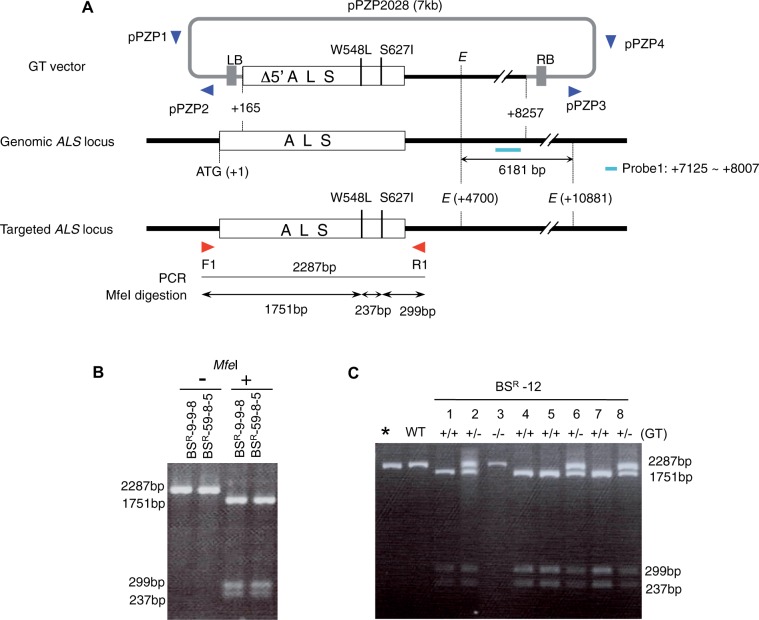
Strategy for T-DNA-mediated GT of the rice ALS locus and analysis of homologous recombination events in T0 plants. Schematic representation of GT events. The white boxes represent the coding region of the ALS gene. The thick black lines represent flanking rice genomic DNA. Left (LB) and right (RB) border sequences are represented by gray boxes. A sequence of 165 bp encoding 55 amino acids including the chloroplast-targeting signal is deleted in the T-DNA region of the GT vector, rendering the ALS gene non-functional. The two mutations (W548L and S627I) that confer BS tolerance exist on the GT vector. The W548L and S627I mutations create novel MfeI restriction sites (CAATTG). The positions of primers (F1 and R1) used for PCR, and the expected size of PCR-amplified fragments and their MfeI endonuclease digestion products are shown. E; EcoRI site. (B) PCR-MfeI CAPS analysis of BSR-9-9-8 and BSR-59-8-5. PCR was performed using primers F1 and R1. The 2,287 bp PCR product resolves to three fragments (1,751, 299 and 237 bp) by MfeI digestion when W548L and S627I mutations are induced in the endogenous ALS locus because W548L and S627I mutations create novel MfeI sites. (C) PCR-MfeI CAPS analysis of BSR-12-1 to BSR-12-8. *Non-digested PCR product of BSR-12-1; other lanes, MfeI-digested PCR products.